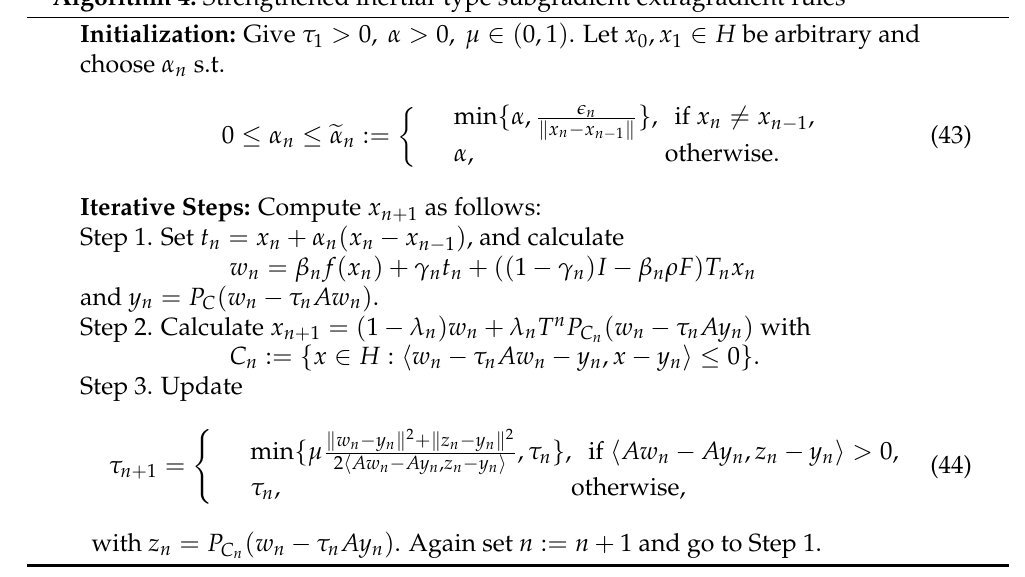
Algorithm 4: Strengthened inertial-type subgradient extragradient